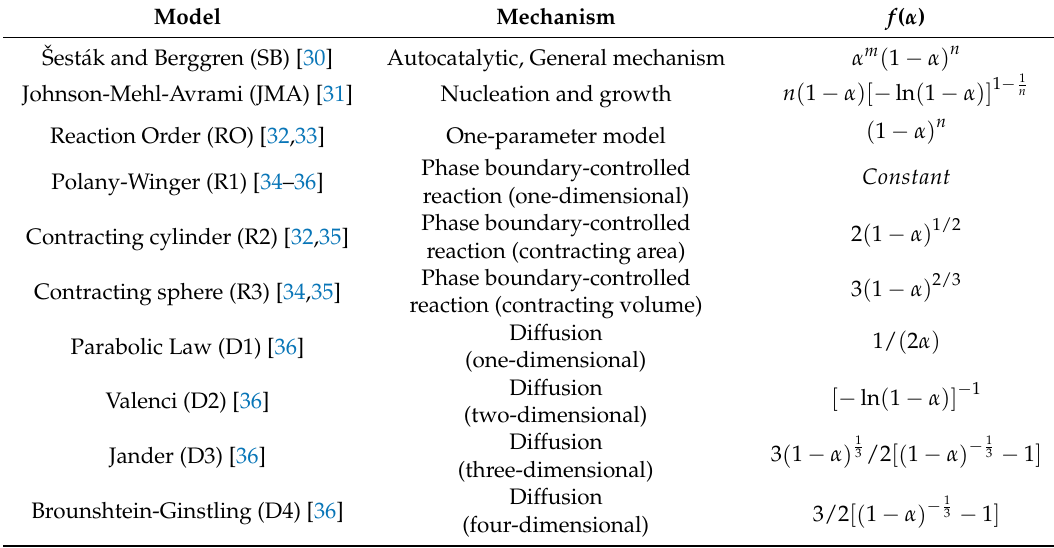
Table 1. Solid-state rate expressions for distinct reaction